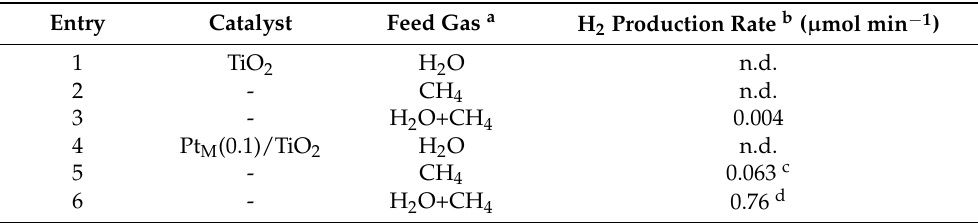
Table 2. Comparison of H 2 production rate using Pt-loaded and unloaded TiO 2 . Reprinted with permission from [40]. Copyright (2008), American Chemical Society.